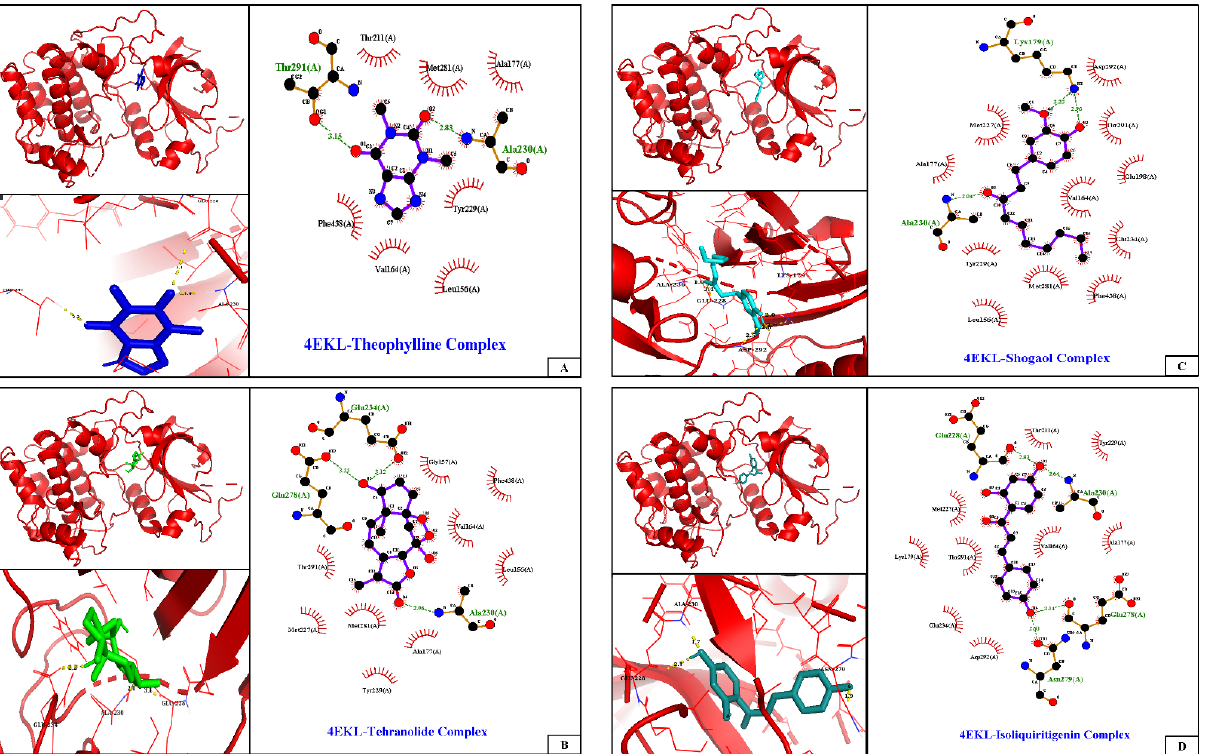
Figure 4. Three-dimensional structure of AKT1 protein (4EKL) with its active site drawn by PyMOL v2.5.0) and the ligand – protein interaction 2D plot for theophylline ( A ), tehranolide ( B ), shogaol ( C ) and isoliquiritigenin ( D ) drawn using Ligplot+ v2.2. H-bonds are designated by dashed lines between the atoms involved, while hydrophobic interactions are depicted by radiating arc towards